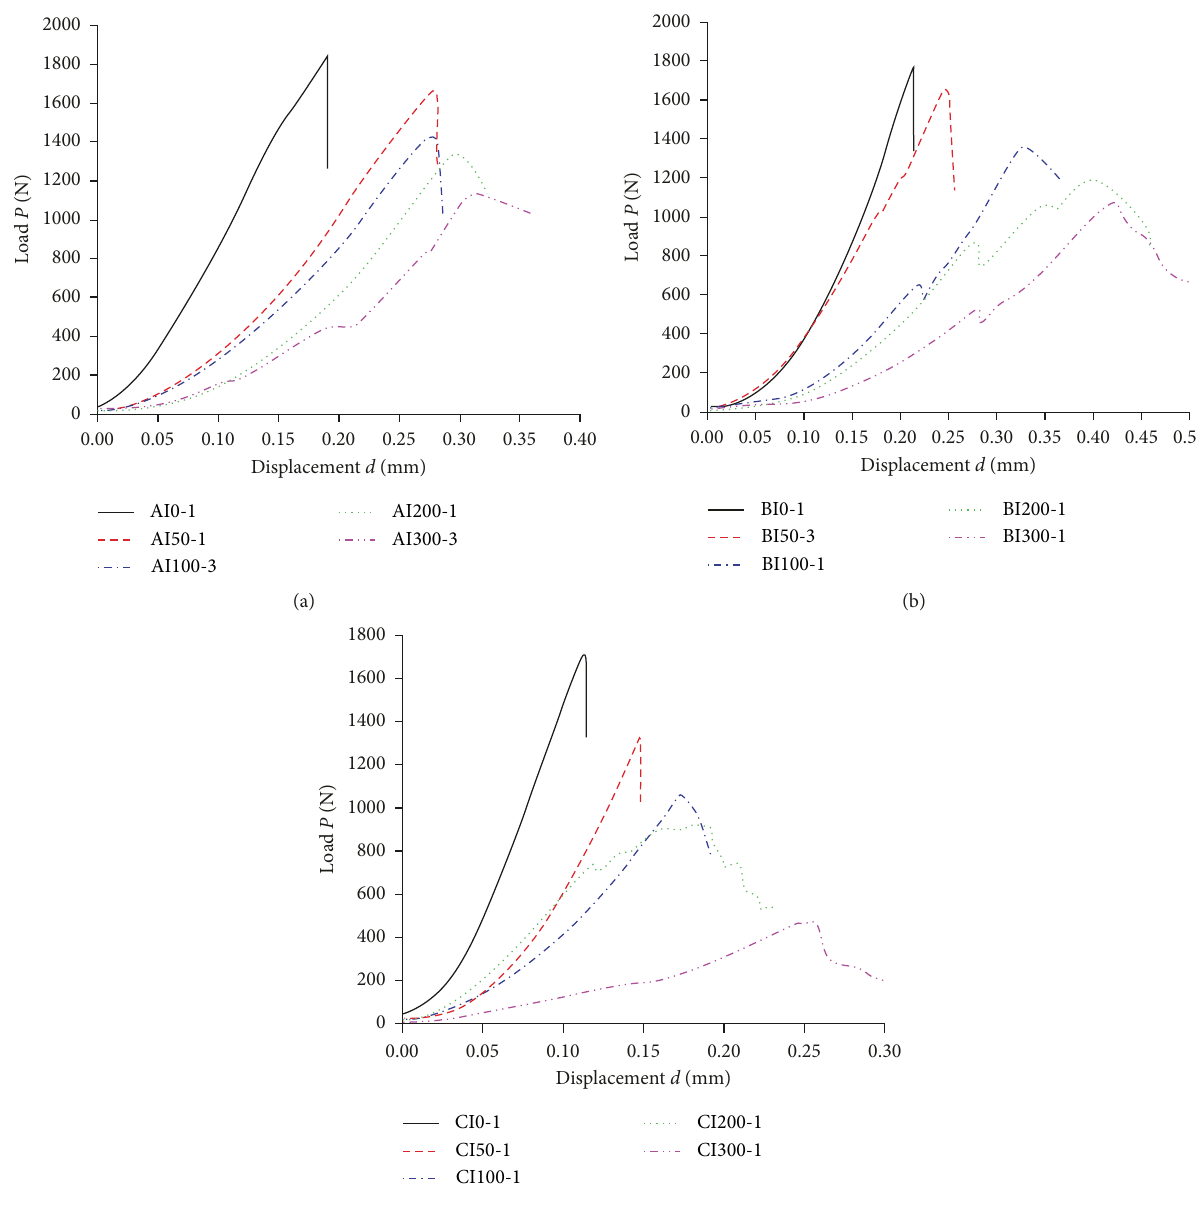
Figure 5: Load-displacement curves of three mudstone specimens after various soaking times. (a) Type A. (b) Type B. (c) Type